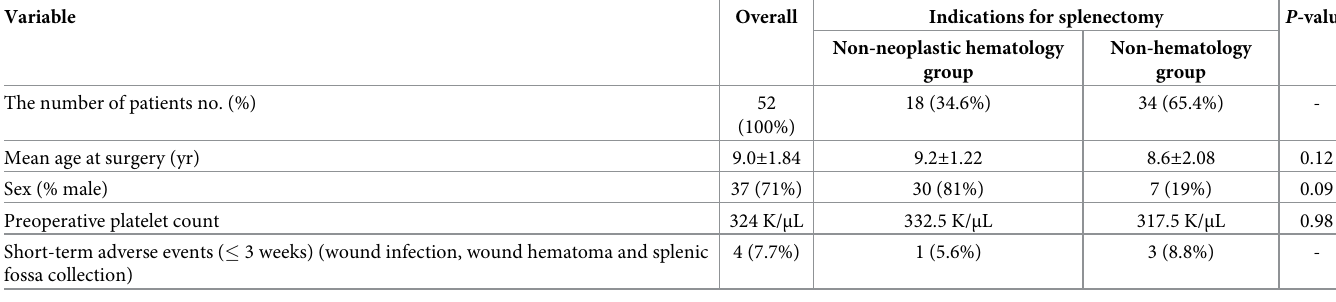
Table 1. The patients’ demographics, their perioperative characteristics, and indications for splenectomy.